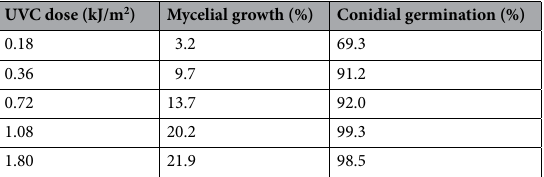
Table 1. Inhibition rate of fungi mycelial growth and conidial germination.